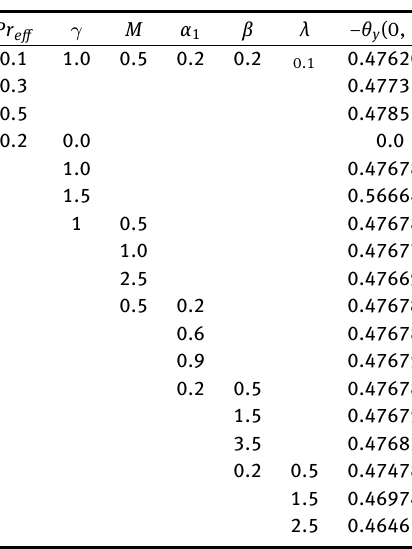
Table 1: The numerical values of effective local Nusselt number − θ (0, τ ) for various values of Pr y Re = 0.5 and τ = π /2